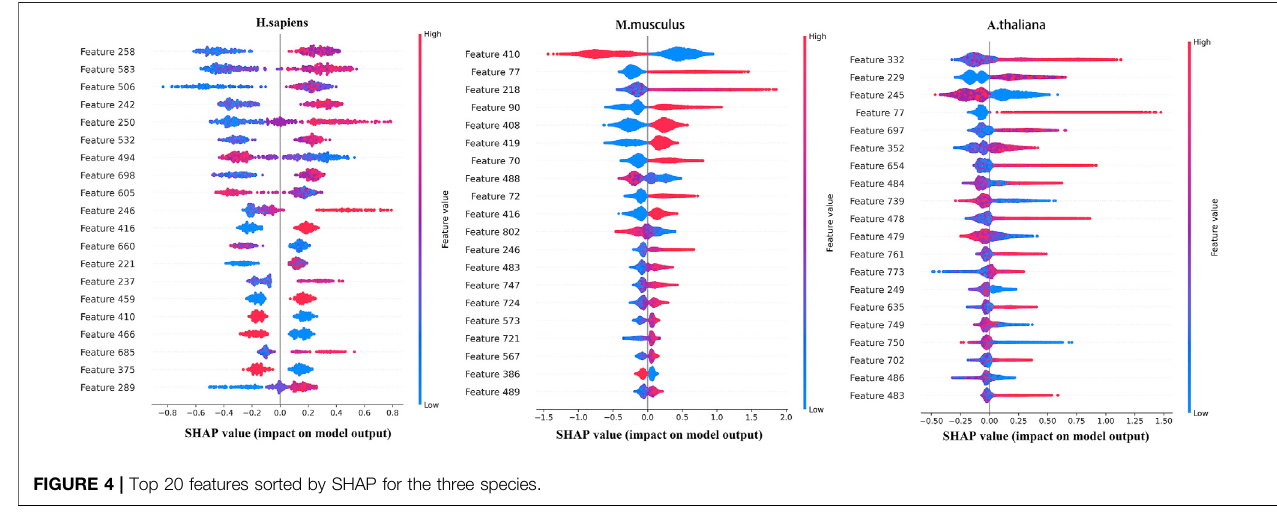
FIGURE 4 | Top 20 features sorted by SHAP for the three species.